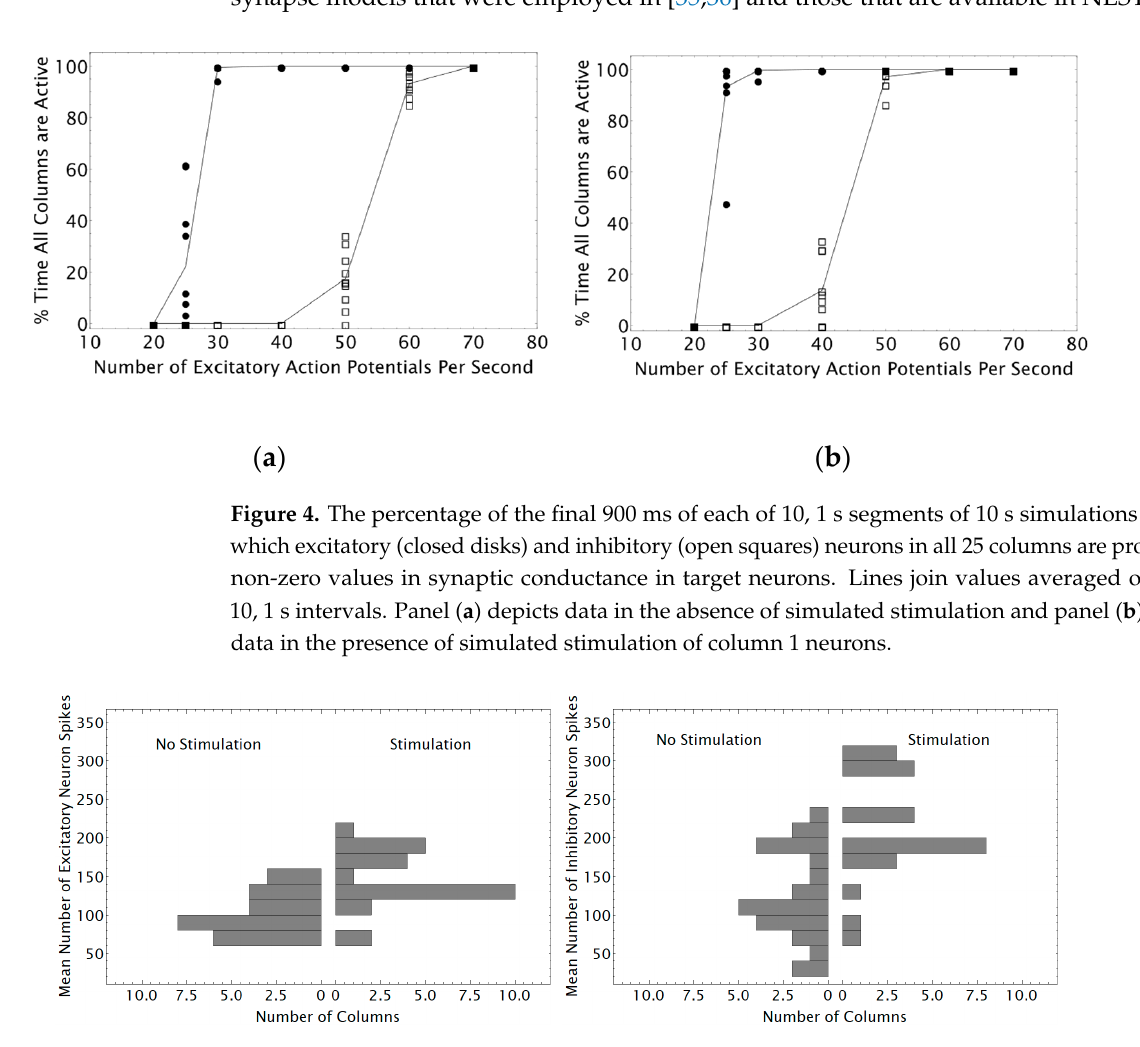
Figure 4. The percentage of the final 900 ms of each of 10, 1 s segments of 10 s simulations during which excitatory (closed disks) and inhibitory (open squares) neurons in all 25 columns are produc- ing non-zero values in synaptic conductance in target neurons. Lines join values averaged over the 10, 1 s intervals. Panel ( a ) depicts data in the absence of simulated stimulation and panel ( b ) shows data in the presence of simulated stimulation of column 1 neurons.